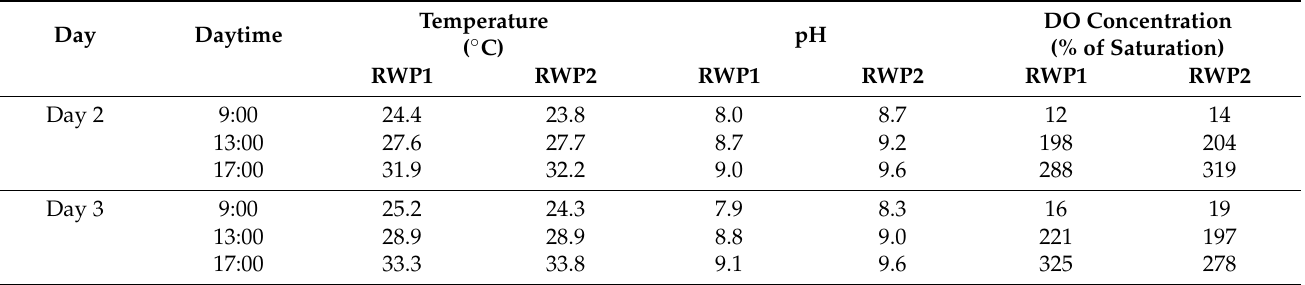
Table 2. Measurements of temperature, pH, and dissolved oxygen (DO) concentration were carried out in the RWP1 and RWP2 bioreactors at 9:00, 13:00, and 17:30 h on days 2 and 3 during outdoor trials. The data are discrete measurements of variables taken after the paddlewheel (position 1 in Figure 1A) as there was little variation along the